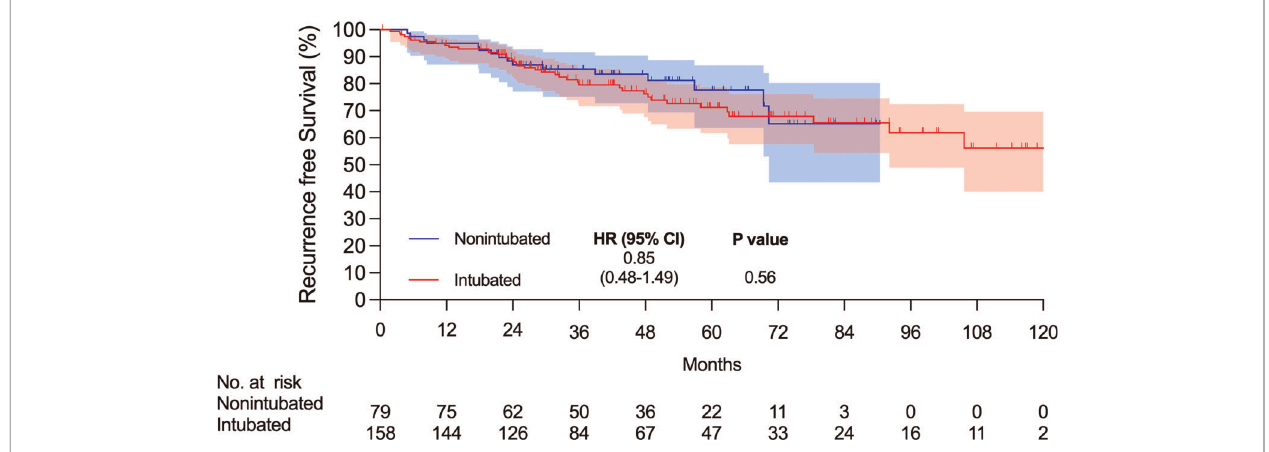
FIGURE 3 | Kaplan – Meier recurrence-free survival curve. Abbreviations: CI, con fi dence interval; HR, hazard